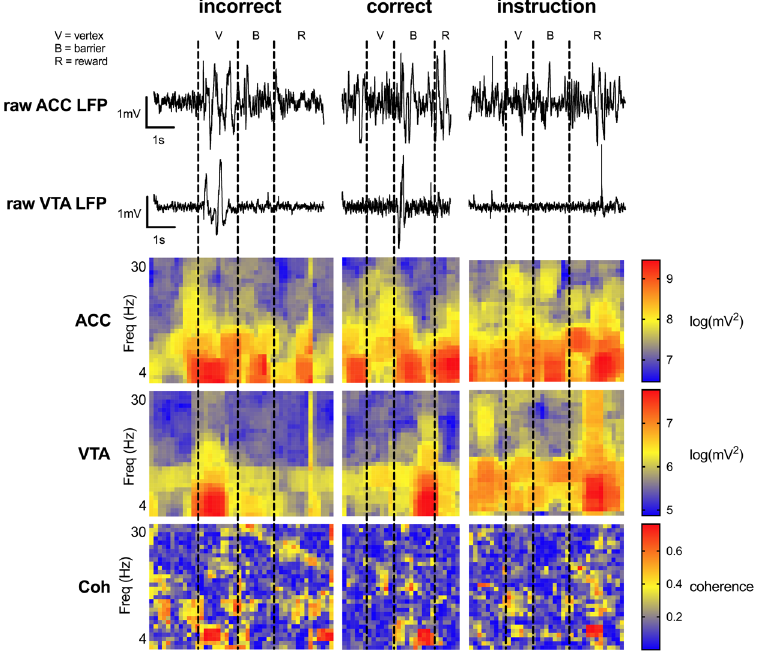
Figure 4. Single trial examples of raw ACC and VTA LFP traces and the spectrograms generated from them for each trial type. These data are from one recording session in rat 4 during phase